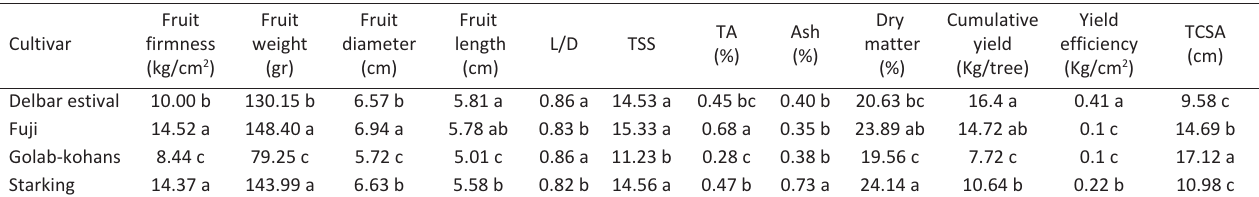
Means with same letters are not significantly different. (P>0.05) using Duncan Multiple Range Test.